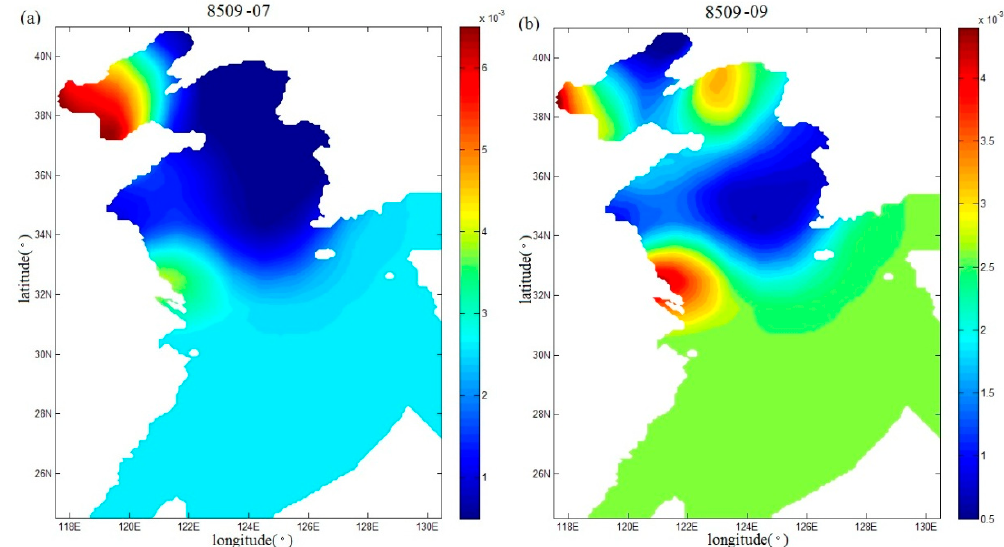
Figure 12. Spatial distributions ( a , b ) of the drag coefficient in the seventh and ninth periods in Case 5 during Typhoon 8509.